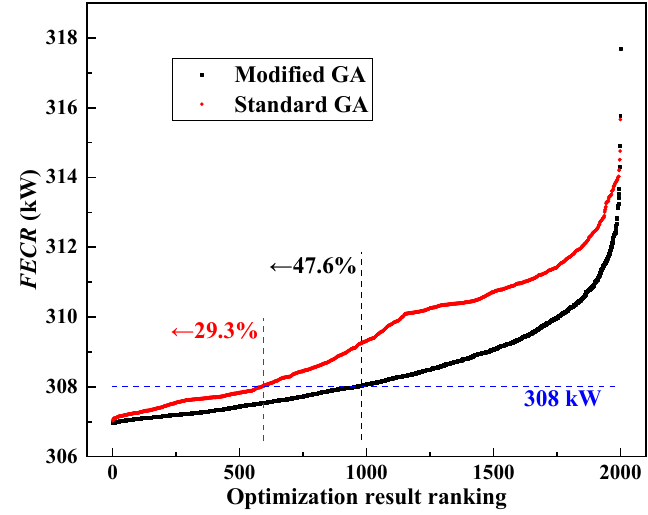
( d ) Figure 4. Distributions of design variables with the corresponding optimal FECR. ( a ) 2000 optimal results over 3000 iterations of standard GA, τ -FECR ; ( b ) 2000 optimal results over 3000 iterations of standard GA, m ram - FECR ; ( c ) 2000 optimal results over 3000 iterations of modified GA, τ -FECR ; ( d ) 2000 optimal results over 3000 iterations of modified GA, m ram - FECR . By comparison, no apparent locally convergent region exists in the results obtained from the modified GA in Figure 4 c,d. Most of the optimized data are located in the globally convergent region. Furthermore, the medians of optimal FECR by using standard and modified GA are, respectively, 309.31 kW and 308.07 kW. It indicates that the proposed modified GA effectively resolves the deficiency caused by the discontinuity when using standard GA. A further comparison in the computational efficiency between the two algorithms can be seen in Figure 5. The above 2000 results, respectively, obtained from standard and modified GA are arranged in the order of FECR from smallest to largest. Due to the dis-